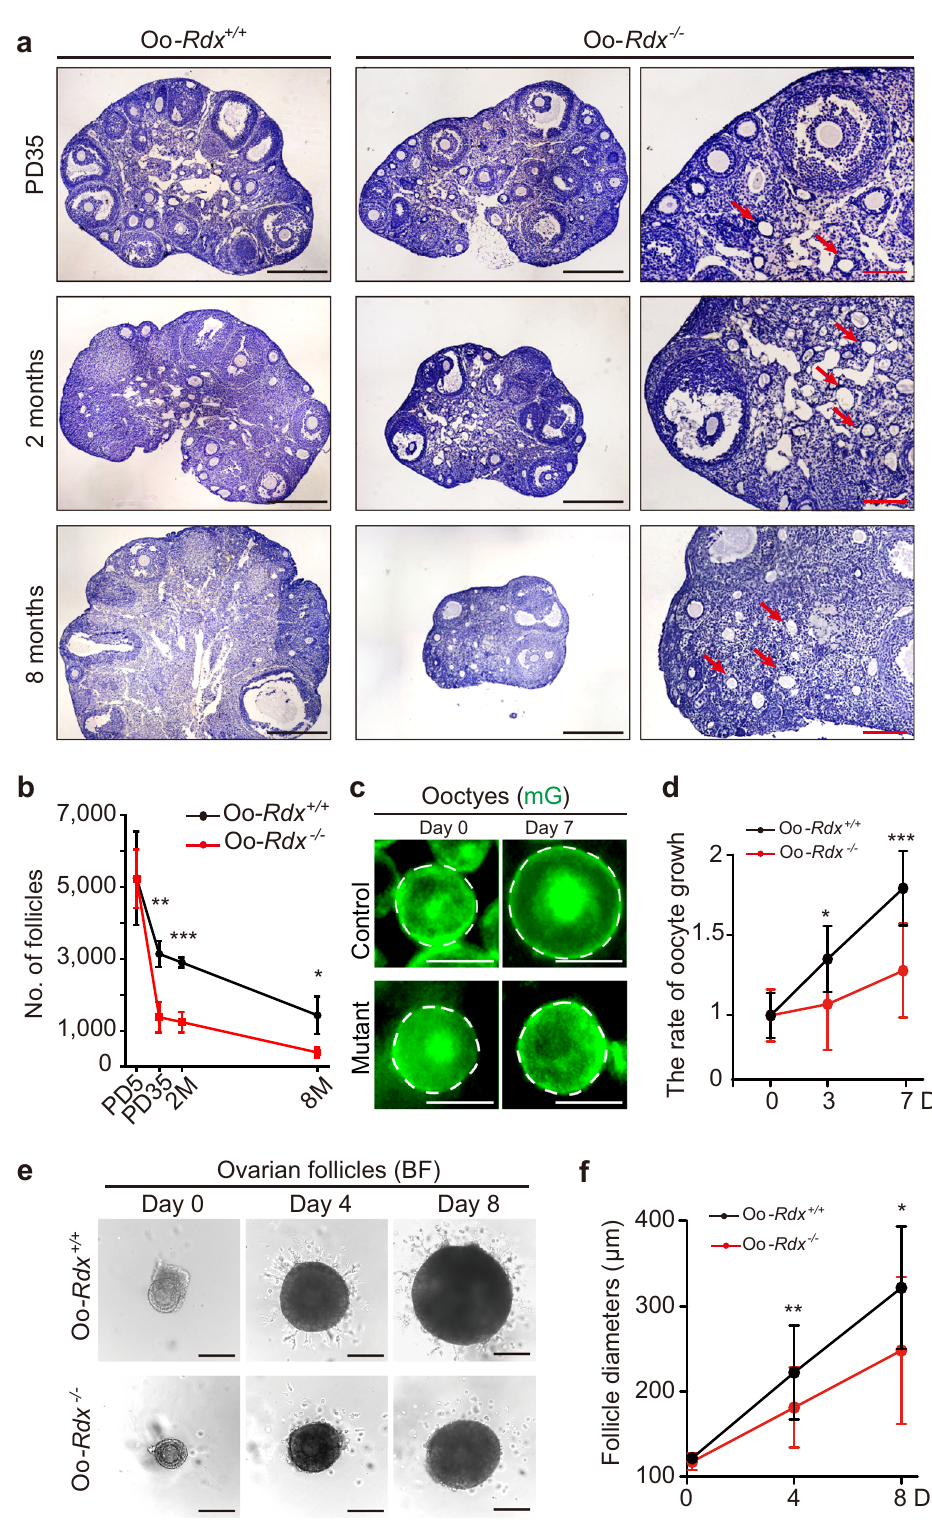
Rdx − / − follicles (Fig. 5h, 60.05 ± 5.72 in Oo- Rdx − / − + GDF9, compared to 26.32 ± 3.00 in Oo- Rdx − / − , and 69.25 ± 4.42 in Oo- Rdx + / + ). Moreover, we found a signi fi cantly decreased